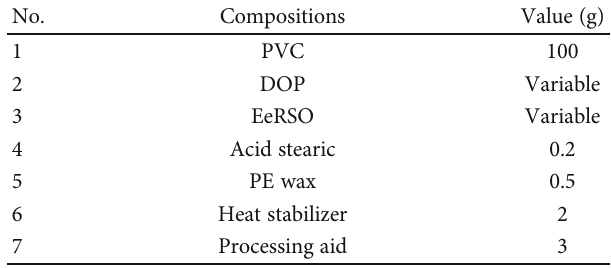
Table 1: The compositions in PVC